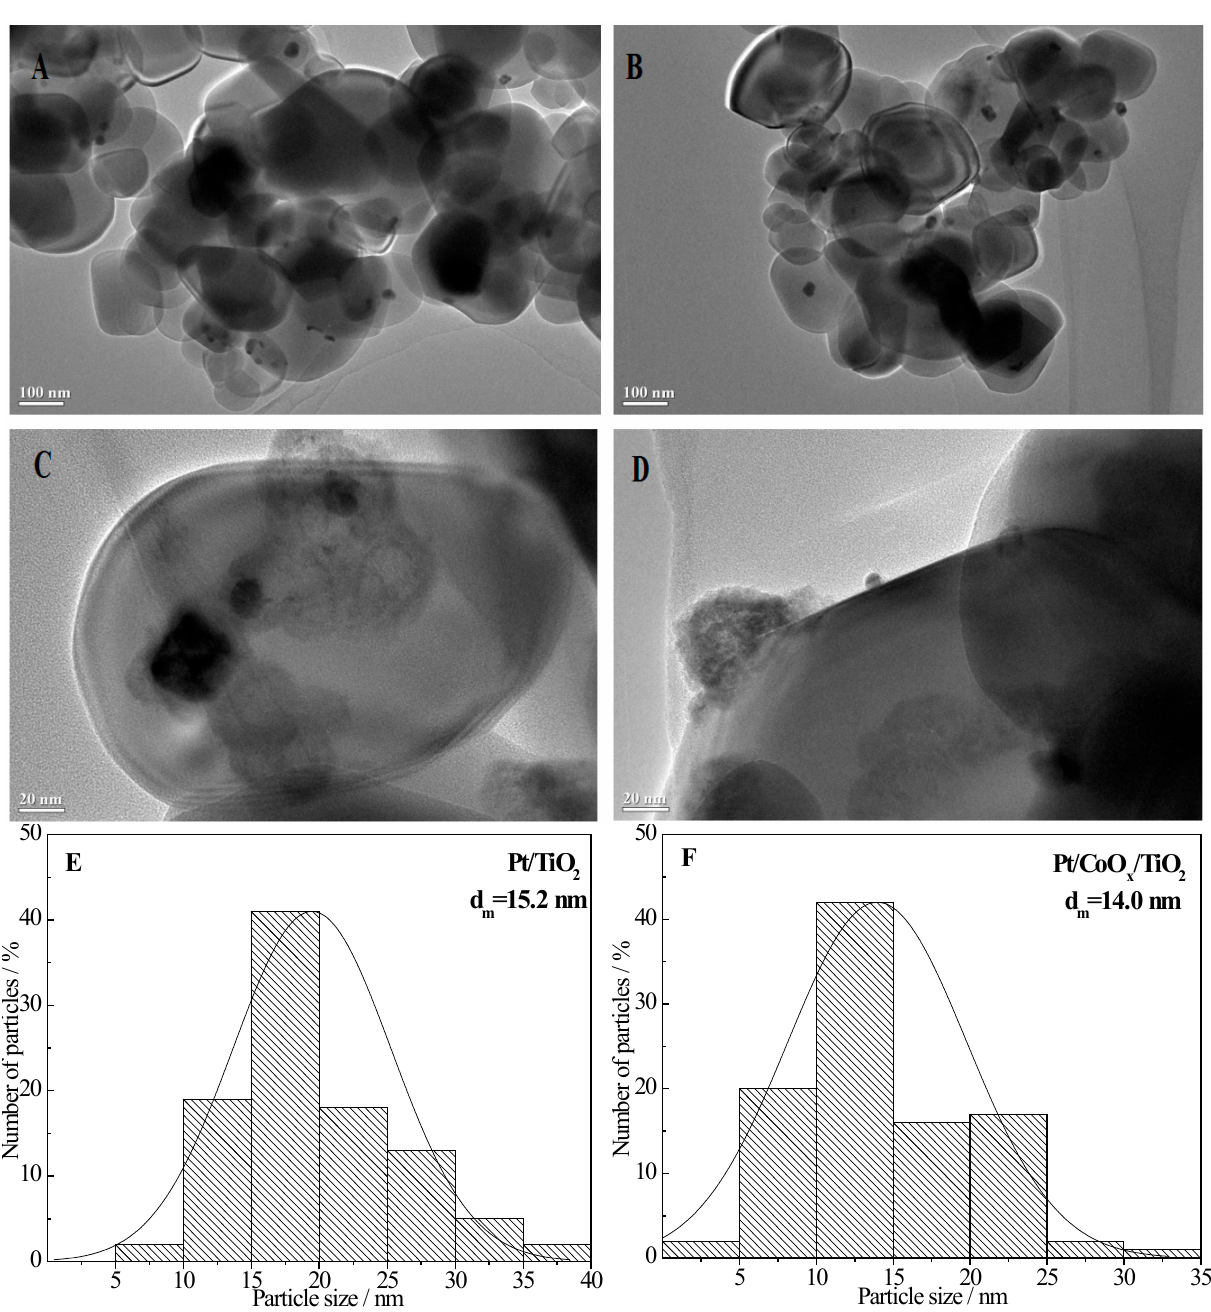
Figure 9. TEM images of the spent Pt/TiO 2 ( A , B ) and Pt/CoO x /TiO 2 ( C , D ) catalysts. Size distributions of Pt particles of spent Pt/TiO 2 ( E ) and Pt/CoO x /TiO 2 ( F